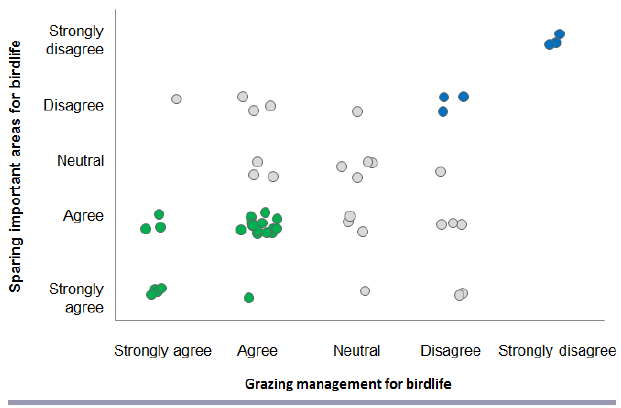
Fig. 6 . Identification of farmers who were willing (green circles) or unwilling (blue circles) to both manage grazing levels and spare important land to benefit birdlife. Grey circles indicate farmers who were either neutral or gave contrasting responses to these two questions. Points have been jittered to prevent overplotting.